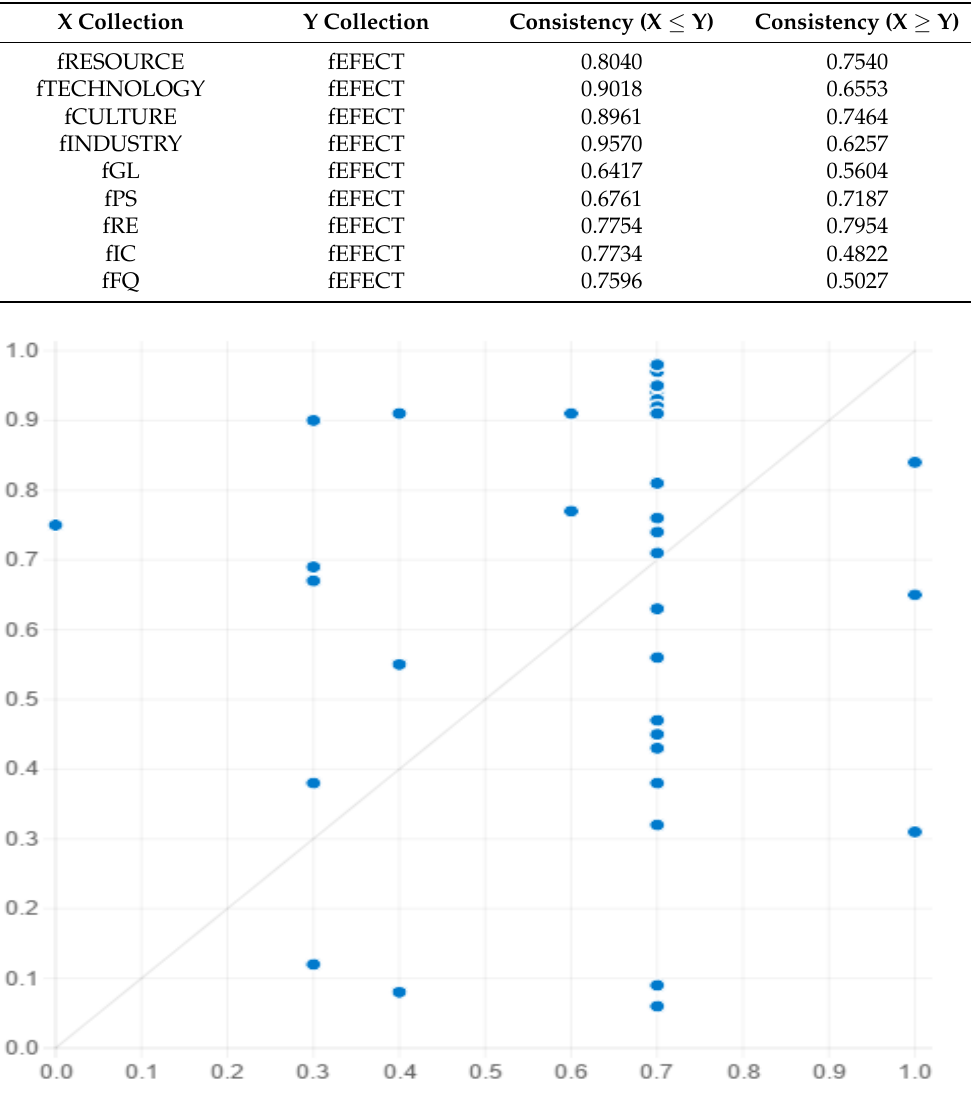
Figure 3. Causality diagram for condition variable fRESOURCE and outcome variable fEFFCT .